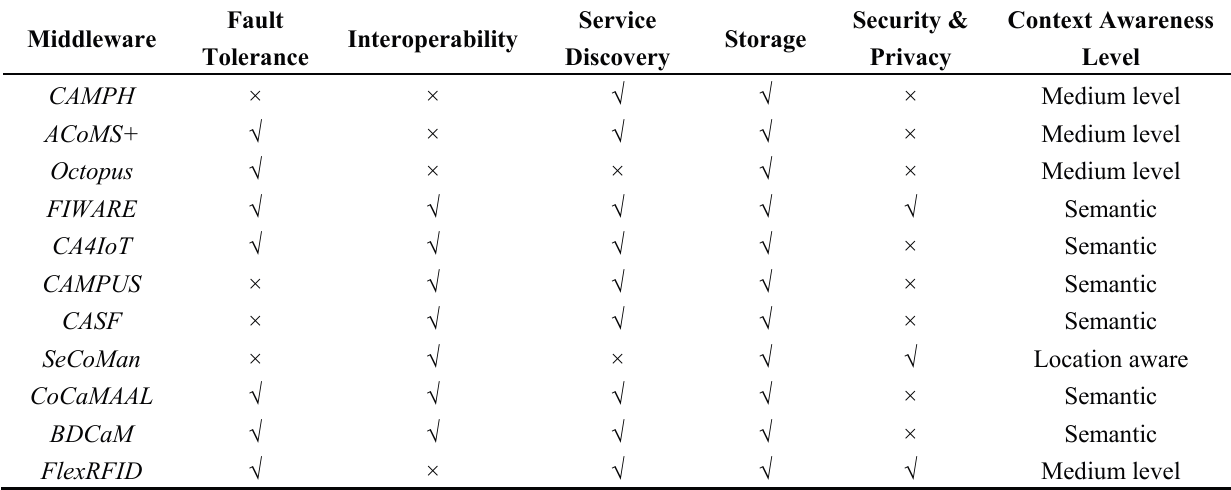
Table 5. Comparison of context aware middleware architectures (Part